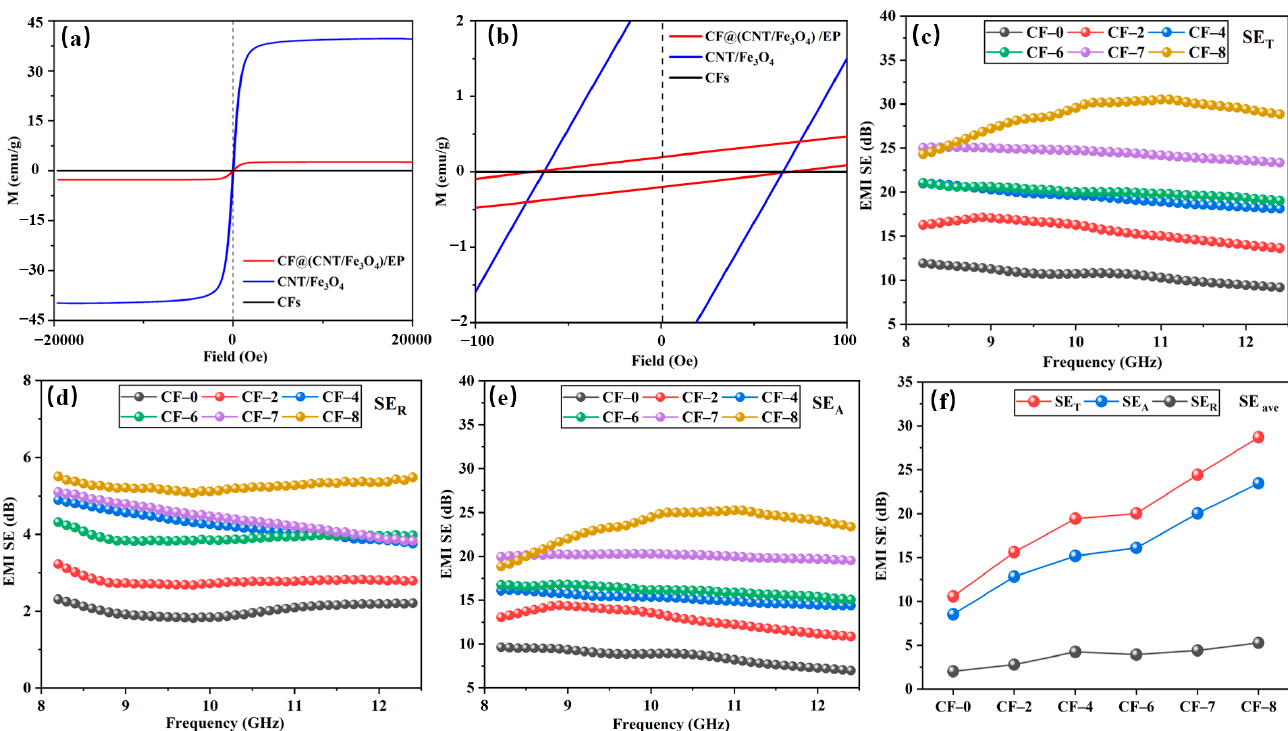
Figure 6. Magnetic hysteresis loops at room temperature ( a , b ), EMI SE T ( c ), EMI SE R ( d ), EMI SE A ( e ) and EMI SE ave ( f ) at 8.2 to 12.4 GHz.